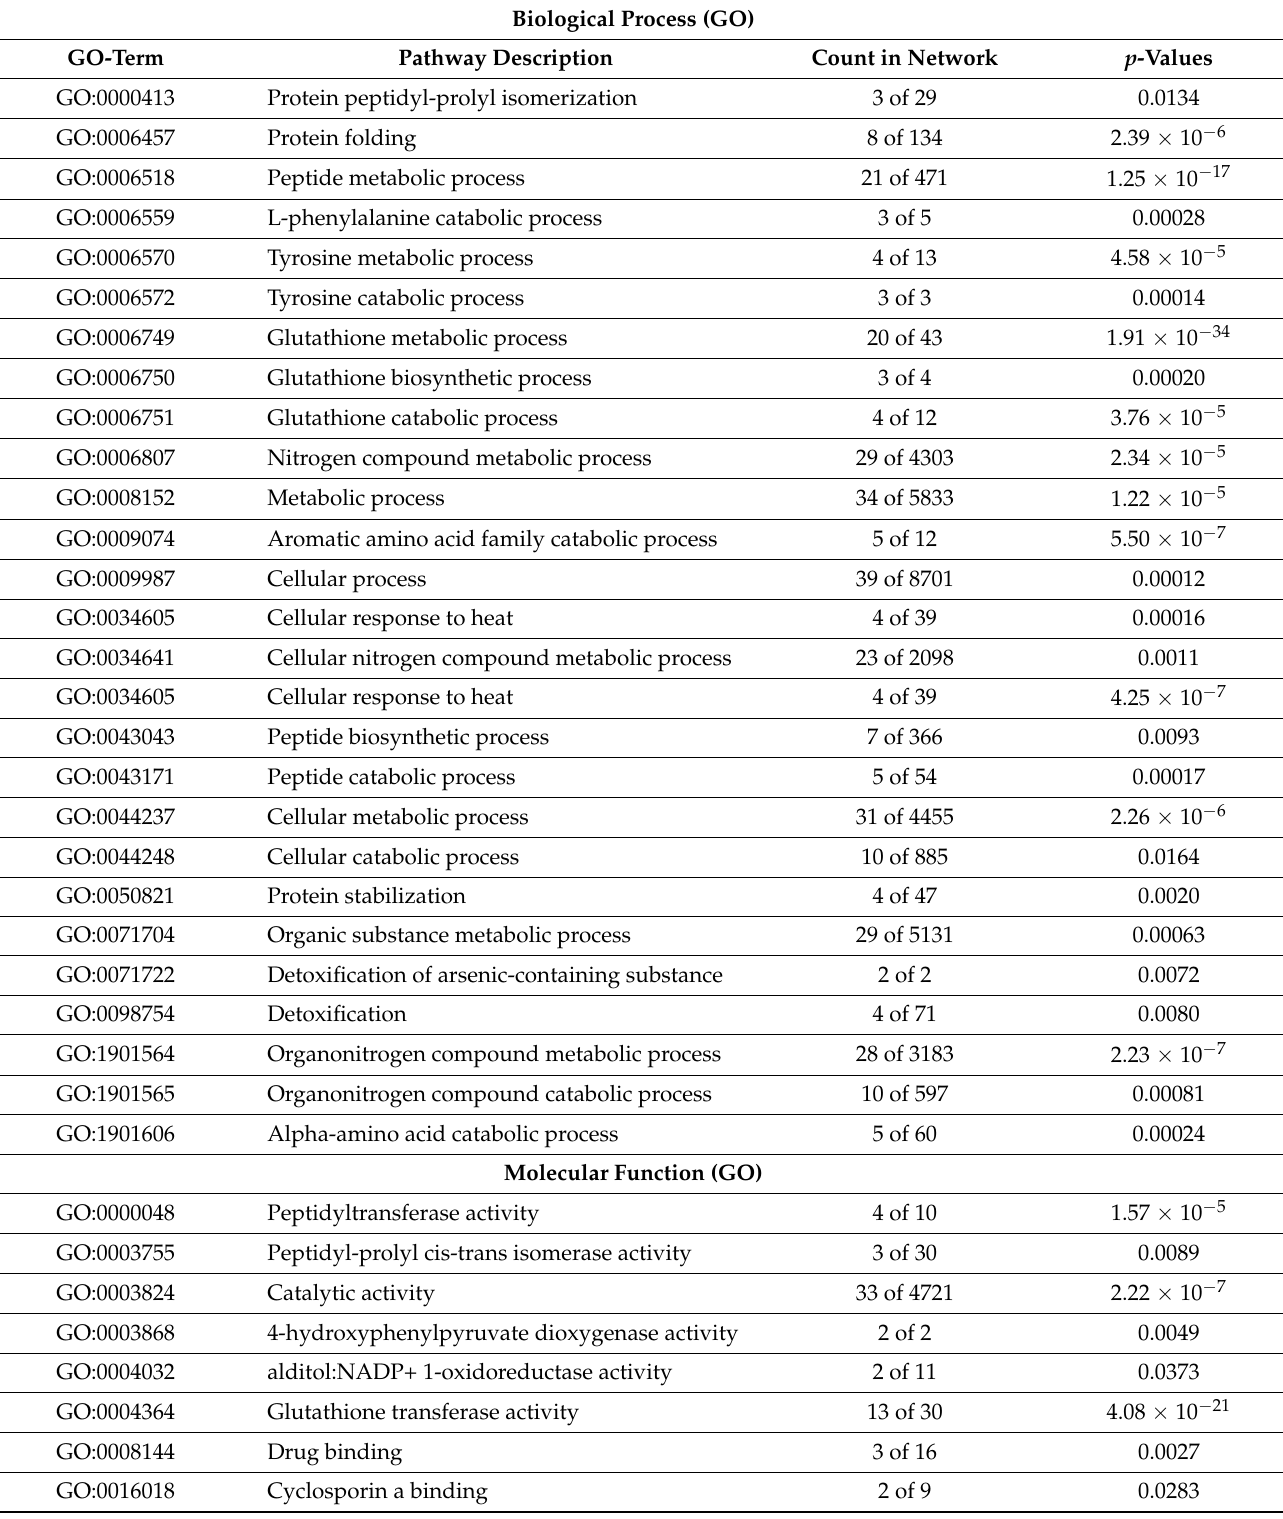
Table 3. Characteristics of biological process and molecular function of protein-protein interaction of GSTs with metabolic detoxification related protein STRING